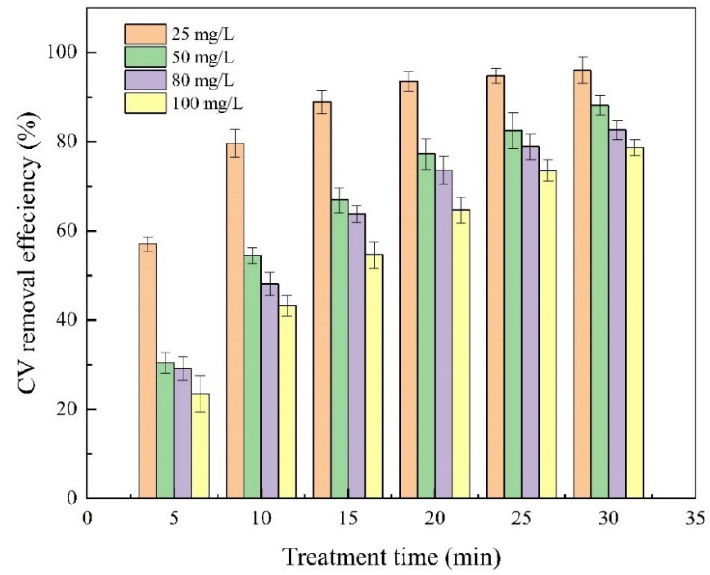
Figure 7. Effect of initial CV solution concentration on the degradation of CV. (Discharge voltage = 22 kV, frequency = 50 Hz, aeration O 2 = 3.0 L/min, red mud dosage = 2.0 g, conductivity = 26 μs/cm).